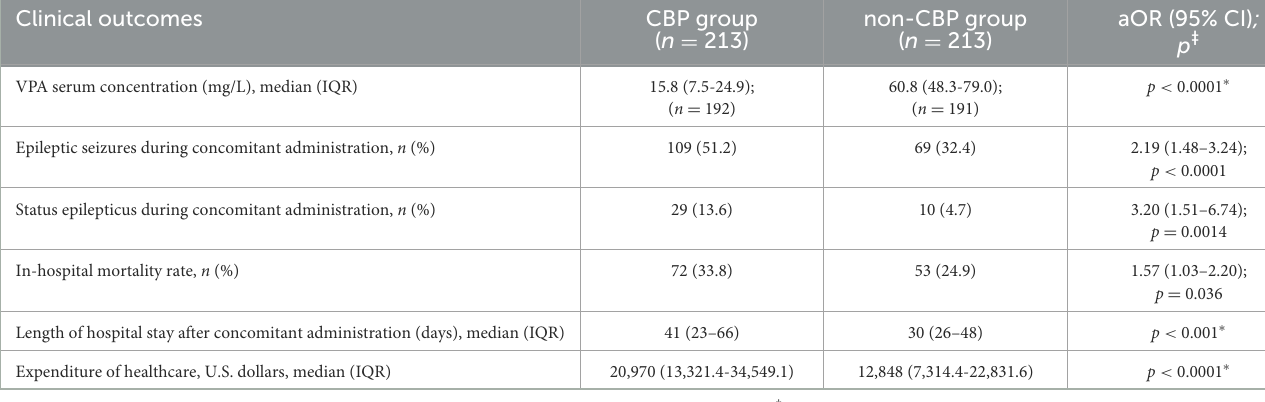
TABLE 3 Comparison of clinical outcomes in propensity-matched groups. Clinical outcomes